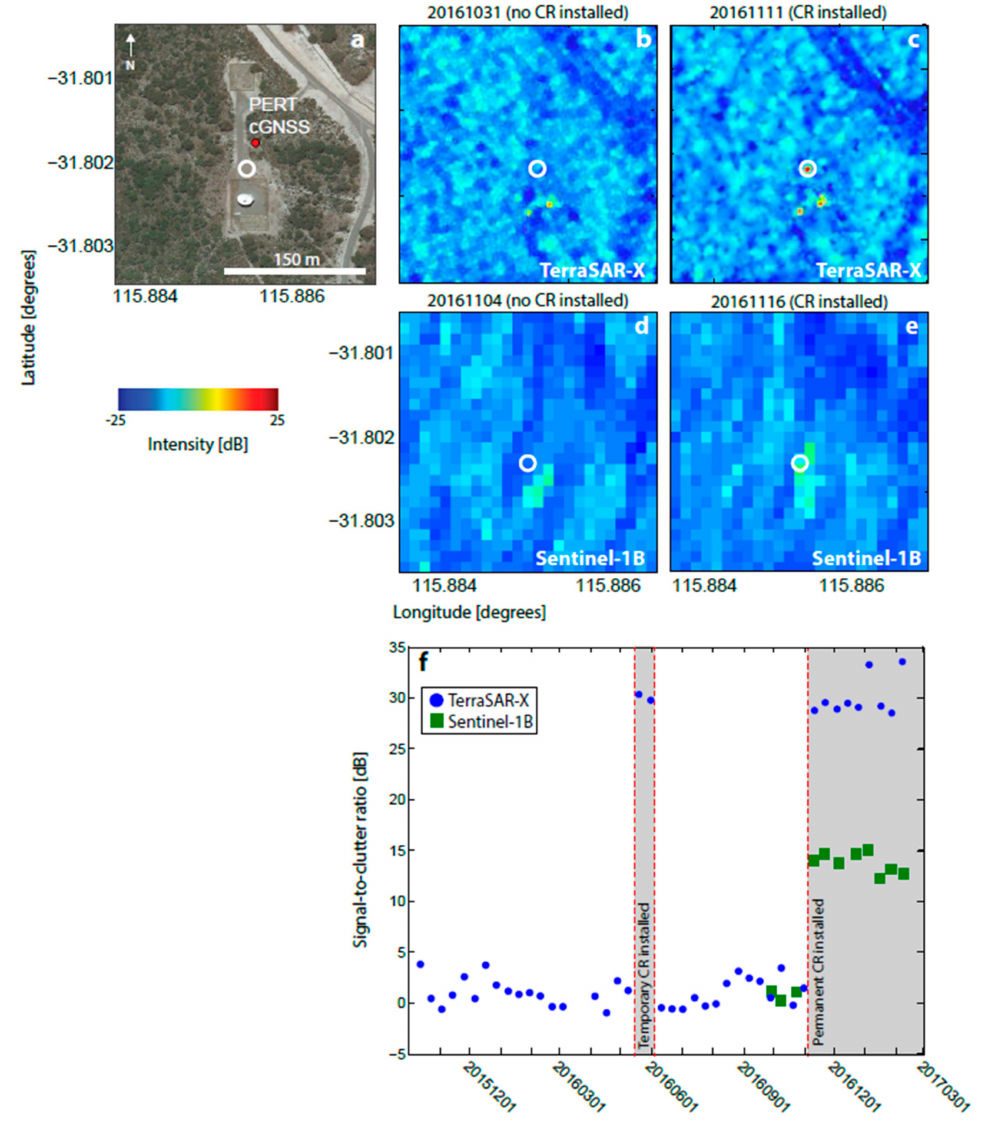
Figure 2. Corner reflector (CR) installation at the existing cGNSS site PERT (location shown in Figure 1). ( a ) Google Earth view of the site showing the cGNSS (red dot) and location of the CR (white circle). ( b ) TSX georeferenced backscatter intensity image prior to CR installation. ( c ) Same as for (b) but after CR installation. ( d ) Sentinel-1B georeferenced backscatter intensity image prior to CR installation. ( e ) Same as for (d), but after CR installation. ( f ) Time series of signal-to-clutter ratio (SCR). Red lines and grey boxes indicate times when the CR was